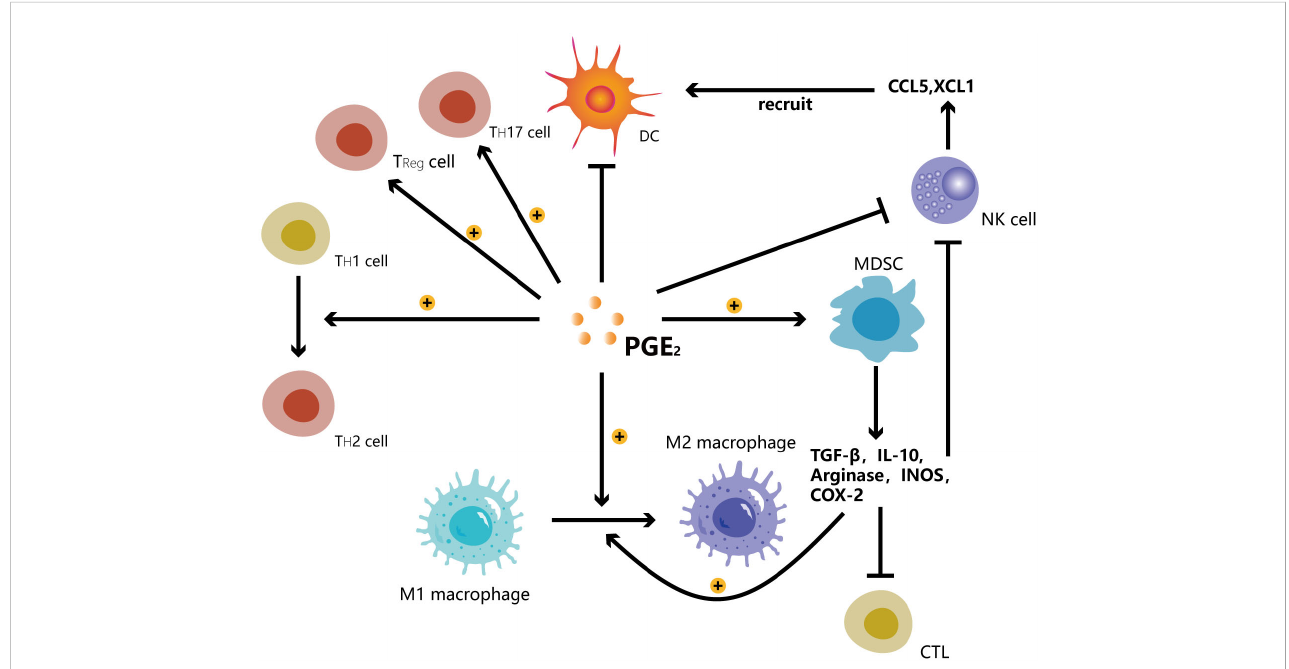
FIGURE 4 PGE 2 promotes the transition of T helper cells from TH1 to TH2 and the shift of macrophages from M1 to M2. PGE 2 induces the development of Treg cells, TH17 cells and MDSCs while inhibiting Dendritic cells, NK cells. MDSCs secrete TGF- b , IL-10, arginase, INOS, COX-2 to promote the shift of macrophages from M1 to M2 while inhibiting the functions of cytotoxic lymphocytes (CTL) and NK cells. NK cells can secrete CCL5 and XCL1 chemokines to recruit